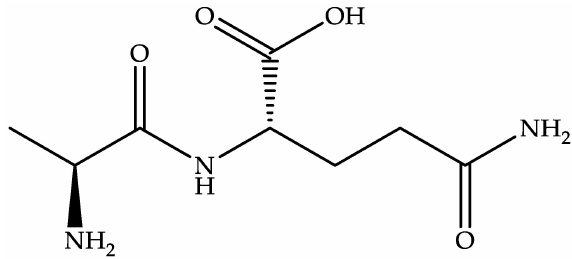
Figure 9. Chemical structure of